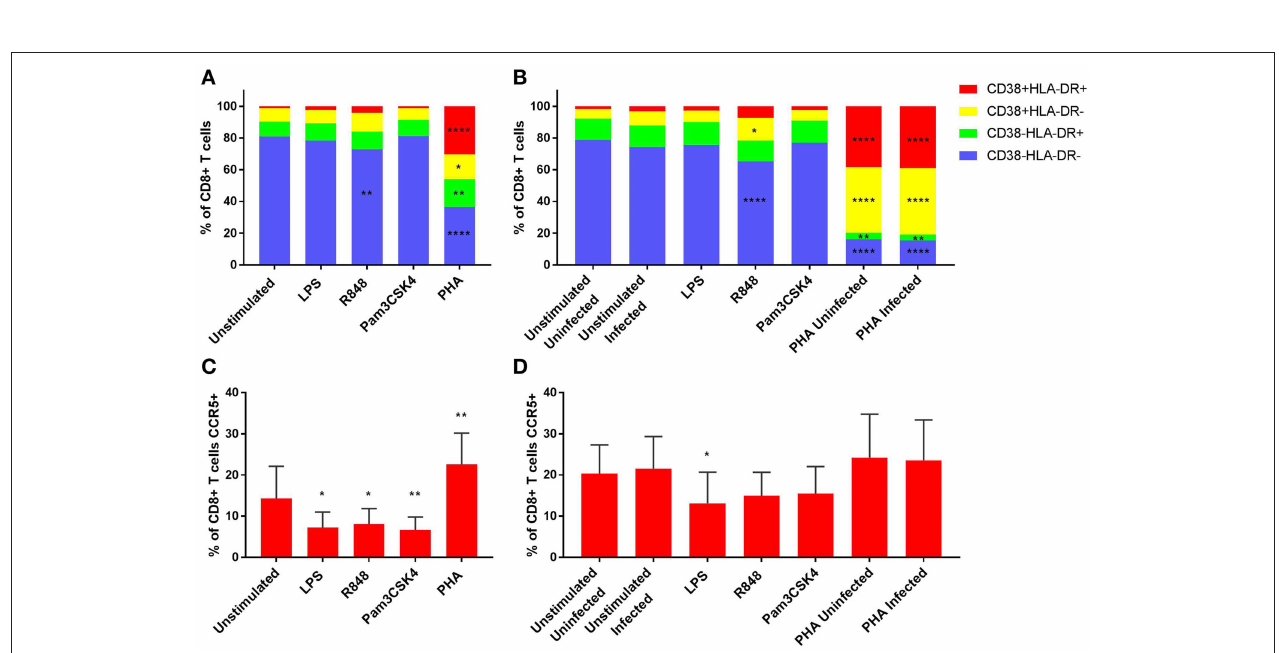
FIGURE 2 | Activation profiles (A,B) and CCR5 expression (C,D) of CD8 + T cells on day 3 prior to HIV infection (A,C) and day 5 post HIV infection (B,D) . PHA was used at a final concentration of 10 µ g/ml. TLR agonists were used at a final concentration of 2 µ g/ml. A repeated measures two-way ANOVA with Dunnett’s multiple comparisons test was used for immune activation, and an ordinary one-way ANOVA with a Dunnett’s multiple comparisons test for CCR5 expression. Significance is displayed as * p < 0.05, ** p < 0.01, **** p ≤ 0.0001 compared to the unstimulated/unstimulated infected control, unless otherwise shown. Sample size, n = 5, 4 donors run in quadruplicate, 1 donor run in